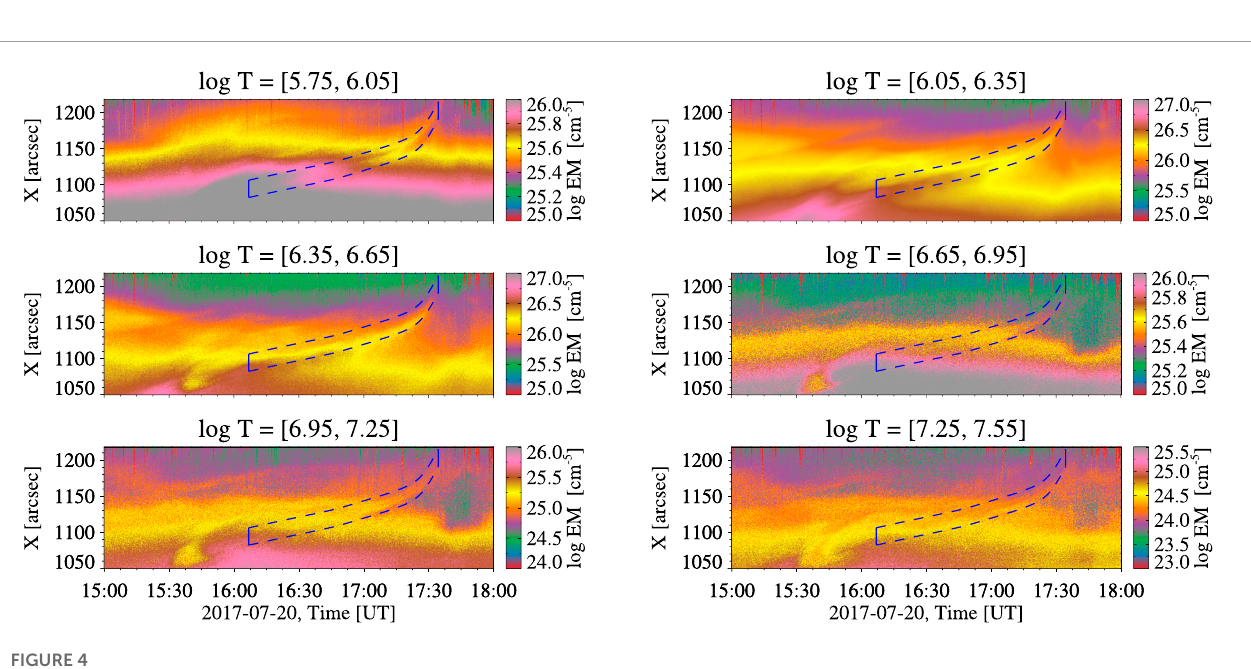
FIGURE 4 The temporal variation in log EM along slit 3 for different temperature bins. The blue dashed curve in all panels of is the same spline curve as in the bottom panel of Figure 3 .